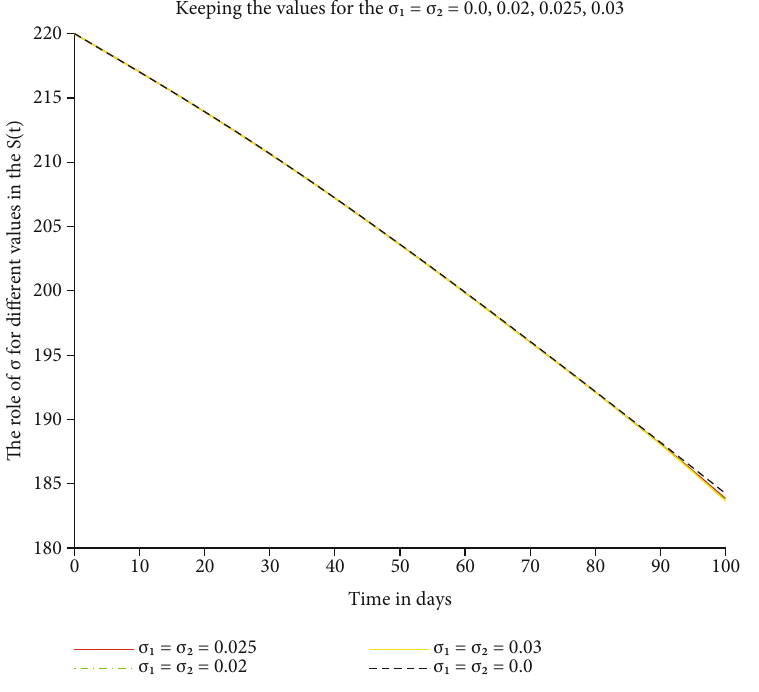
Figure 1: Joint solution of the given model (1) of COVID-19 for the order